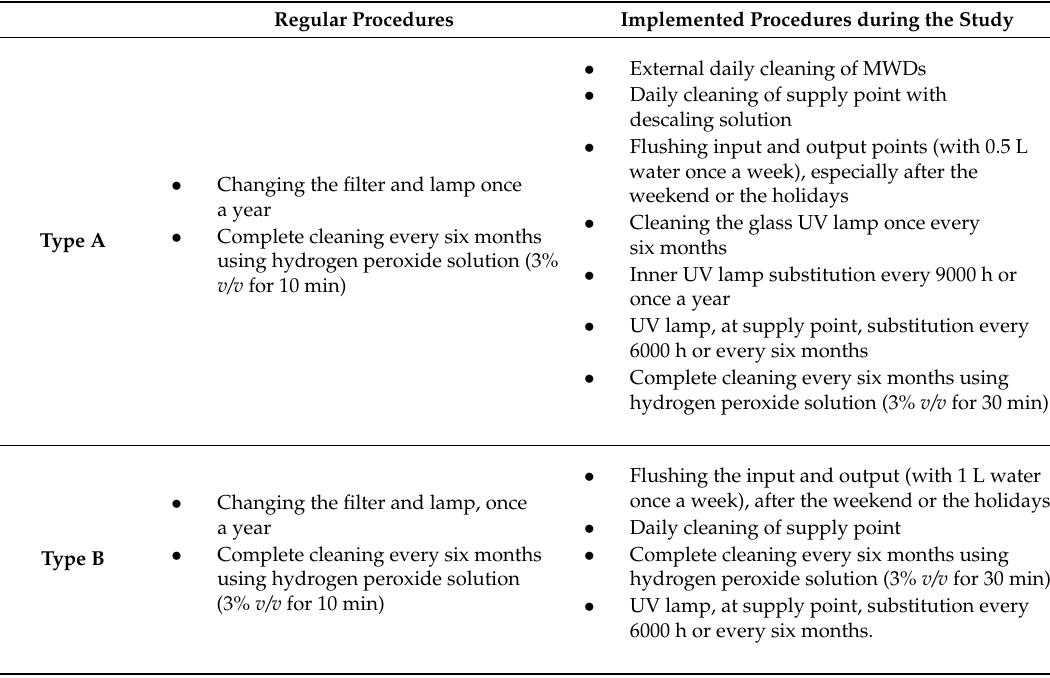
Table 3. Regular and implemented procedures in Type A and Type B MWDs.